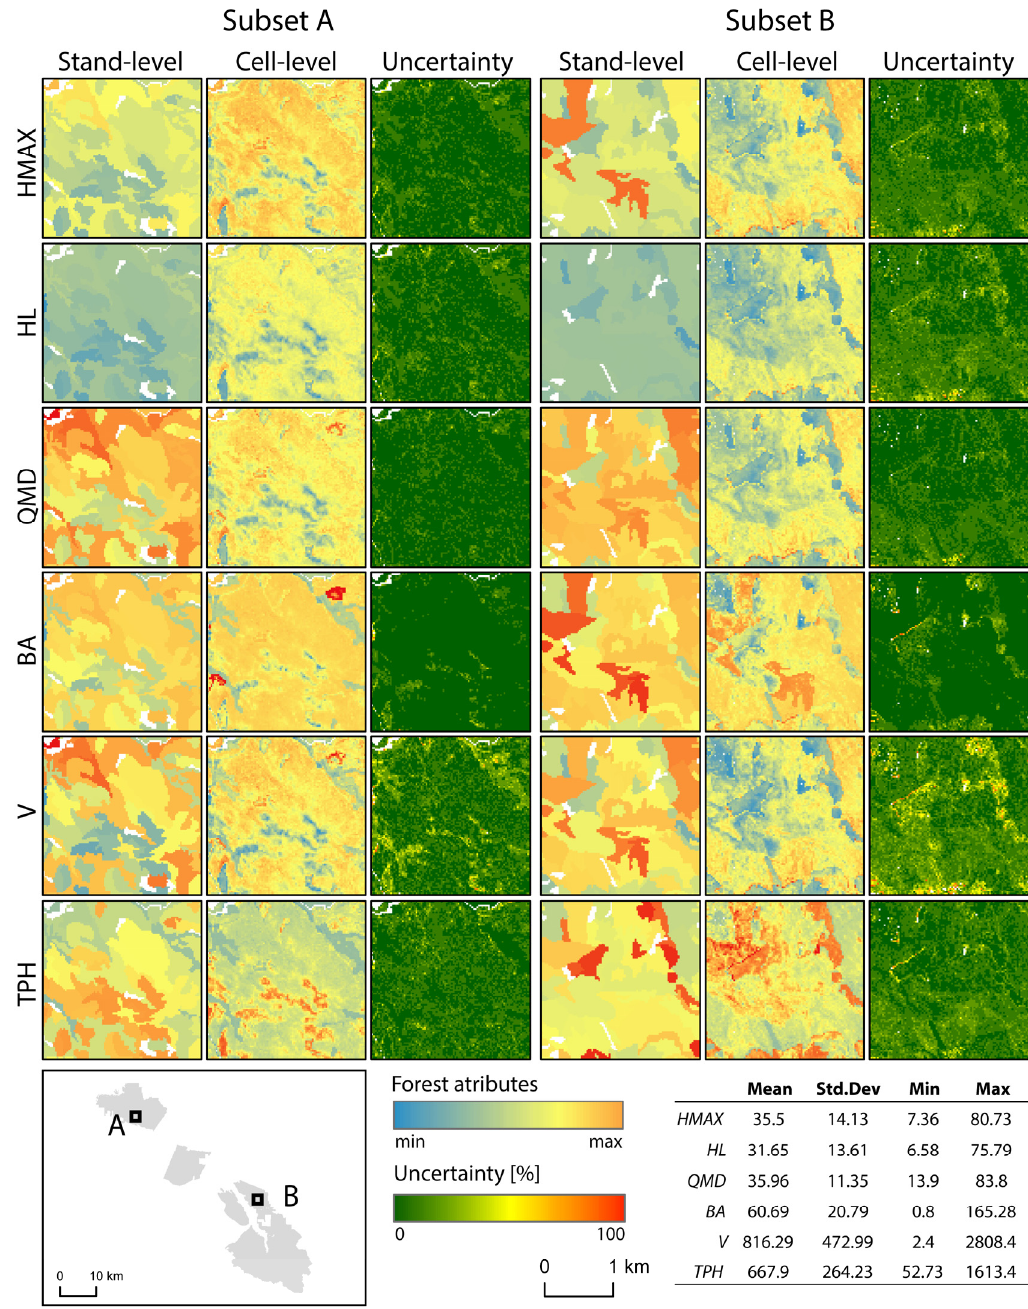
Figure 3. Two subsets of stand attribute predictions at stand ‐ and cell ‐ level, and their respective uncertainties. Descriptive statistics calculated for the cell ‐ level predictions are presented in the bottom ‐ right corner of the figure.